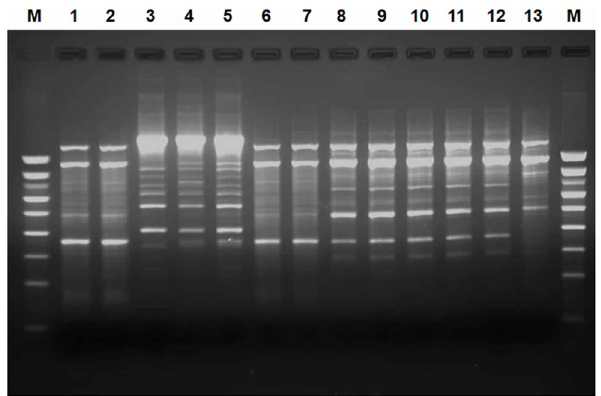
Figure 3. Representative ERIC-PCR fingerprint of different between Salmonella isolates on 2 per cent agarose gel. M: 1000 bp DNA marker; lane 1 to 13: F34 9 , F35 9 , C31 9 , C32 9 , C33 9 , C34 9 , C36 9 , L1, L2, L3, L4, L5 and L9. A 1000 base pair Smart Ladder (Eurogentec, France) was included